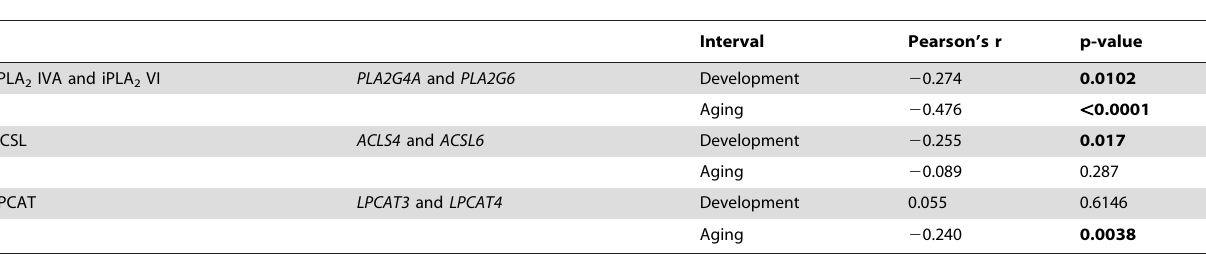
Table 4. Correlation between AA and DHA